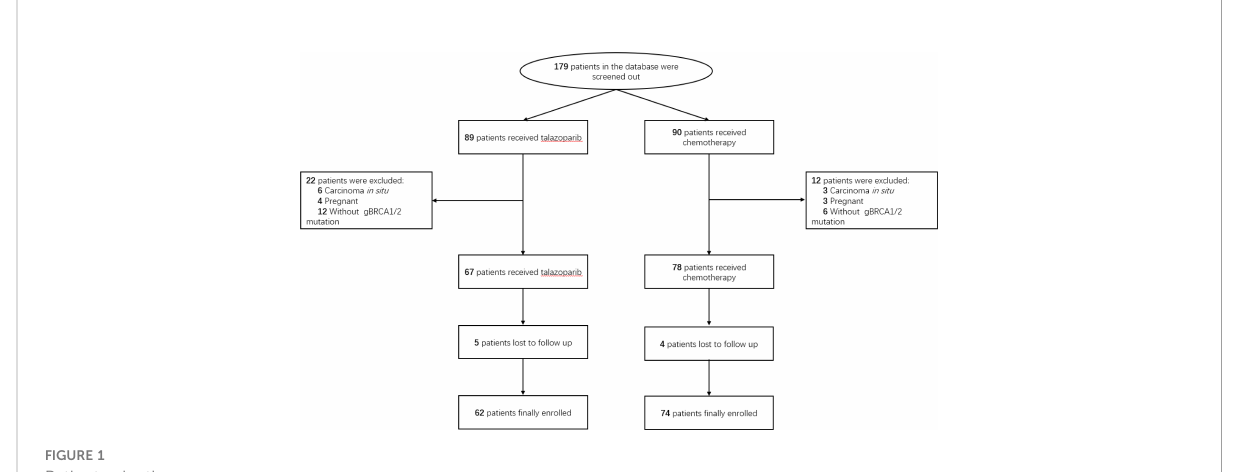
FIGURE 1 Patient selection